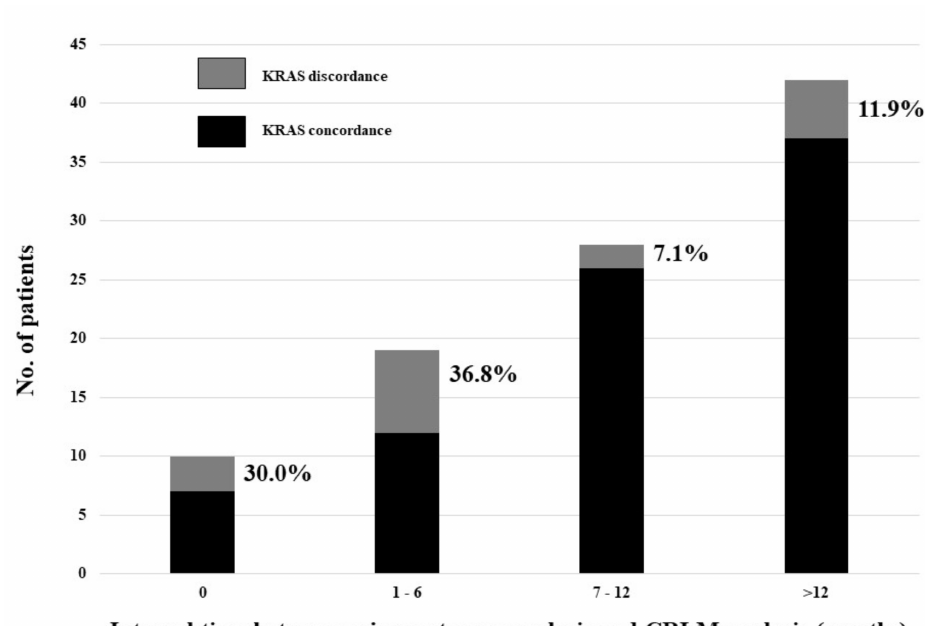
Figure 2. Incidence of KRAS discordance according to the time interval between the KRAS mutation analysis of the primary colorectal tumor and the mutation analysis of the corresponding CRLM.